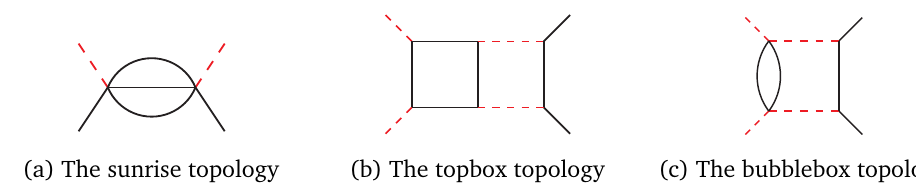
Figure 2: Topologies in the topbox family that are associated with the elliptic curves E ( a ) , E ( b ) and E ( c ) . Black-solid lines correspond to massive particles, red-dashed lines correspond to massless particles. This figure is from [ 13 ] licensed under CC-BY